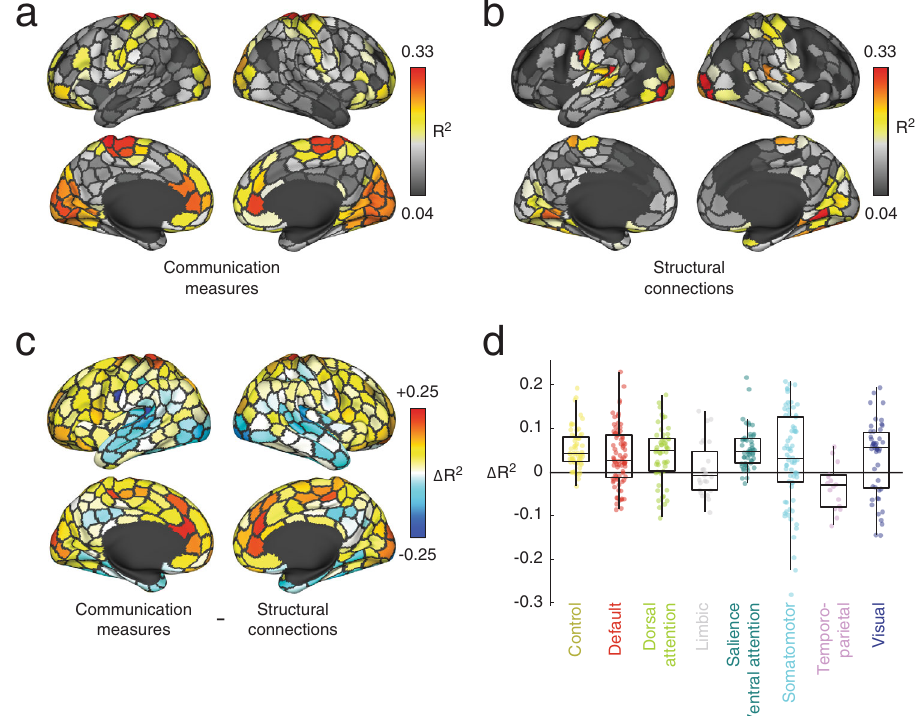
Fig. 4 Comparison of communication measures and structural connectivity in predicting FC. In the main text we derived a series of communication measures from sparse structural connectivity (SC) data to predict regional FC patterns. Here, we compare the results from the communication measures with the results obtained from using the structural connections directly. In this analysis, we create a “ mask ” for each region and subject of its structural connections to other regions. We then extract the weights of those structural and functional connections and fi t a linear model to explain the functional connection weights in terms of the structural weights. This results in an R 2 value for each region and subject. a Variance explained using communication measures averaged across subjects. b Variance explained using structural connections alone averaged across subjects. c Regional differences in variance explained. Warmer and cooler colors indicate regions whose FC is better predicted using the communication measures and structural connectivity, respectively. d Data from panel c but displayed by brain system. Each point represents a brain region ( N = 400 parcels de fi ned based on 40 ). In each boxplot, the “ box ” denotes interquartile range (IQR), the horizontal bar indicates the median value, and the whiskers include points that are within 1.5 × IQR of upper and lower bounds of the IQR (25th and 7th percentiles). Any points that fall beyond the whiskers are, by convention, considered outliers. Source data are provided as a Source Data fi